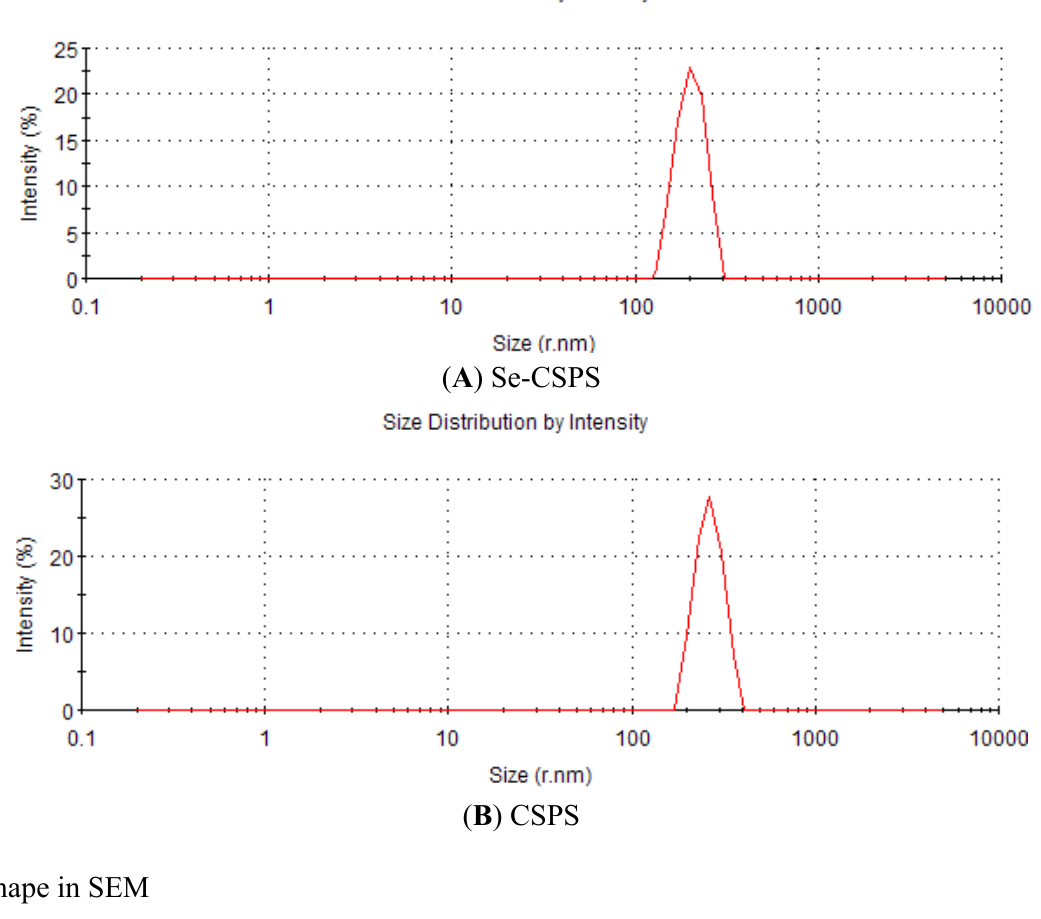
Figure 5. Particle size distribution curves recorded for ( A ) Se-CSPS and ( B ) CSPS.